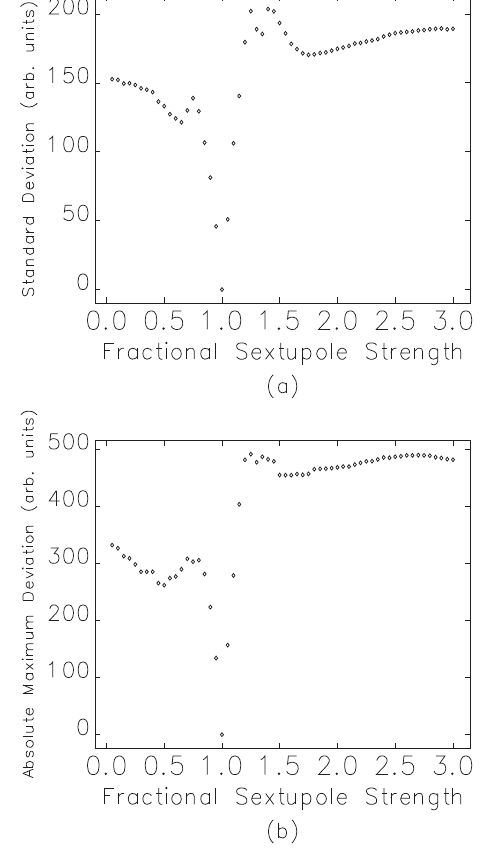
occur.FIG. 9. The standard deviation (a) and the maximum deviation (b) of the energy spectrum minus the baseline as the sextupoles are scaled from 0 to 300% of the correct sextupole set point for linearizing a bunch at full compression after BC1. For both calculations, the edges of the distribution are